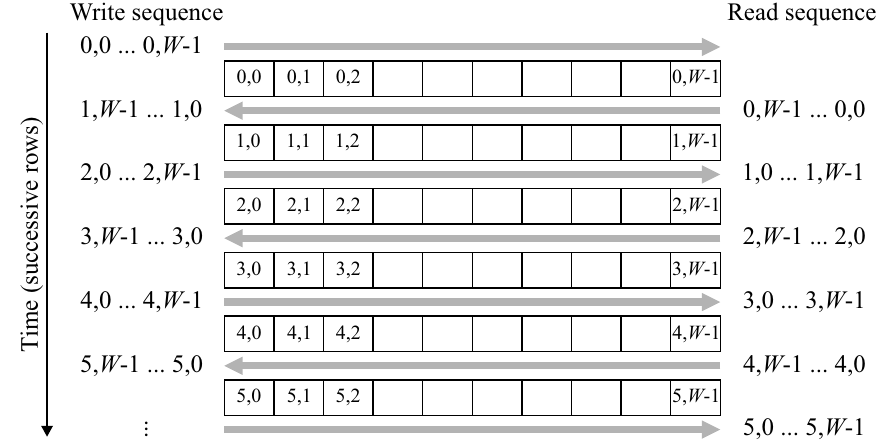
Figure 8. Operation of the row buffer with zig-zag ordered